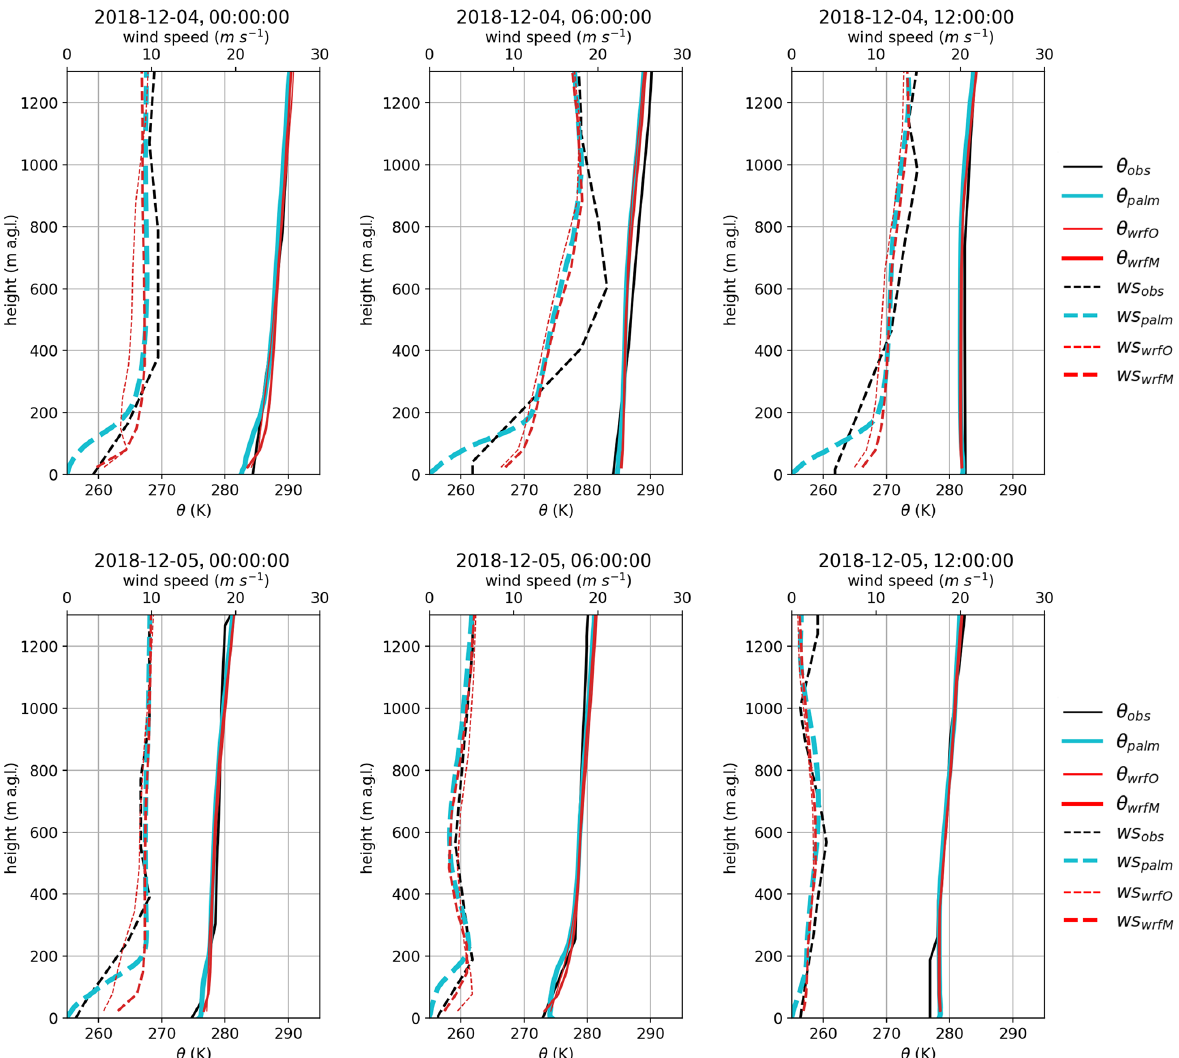
Figure 6. Vertical profile of potential temperature and wind speed from the radiosonde observations at Praha-Libuš station, with correspond- ing WRF (1km horizontal resolution) and PALM (average from parent 10m resolution domain) profiles for 4–5 December. The potential temperature is represented by the solid lines, and the wind speed is denoted by the dashed lines. The black line is the sounding observation, the cyan line is the PALM model, and the red line is the WRF model. The thin red line is the WRF model at the sounding location, and the thick red line is the WRF model in the centre of the PALM